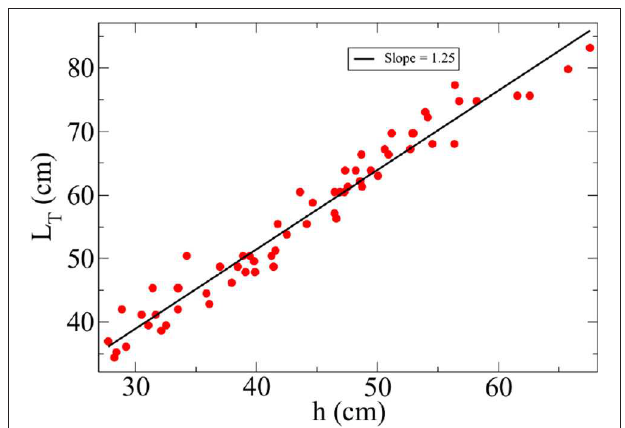
FIGURE 7 | The length L T of the upwards moving part of the chain as a function of fountain height h as measured by simulations.